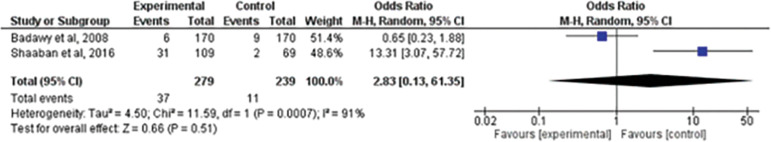
Forest-plot of preeclampsia incidence with treatment